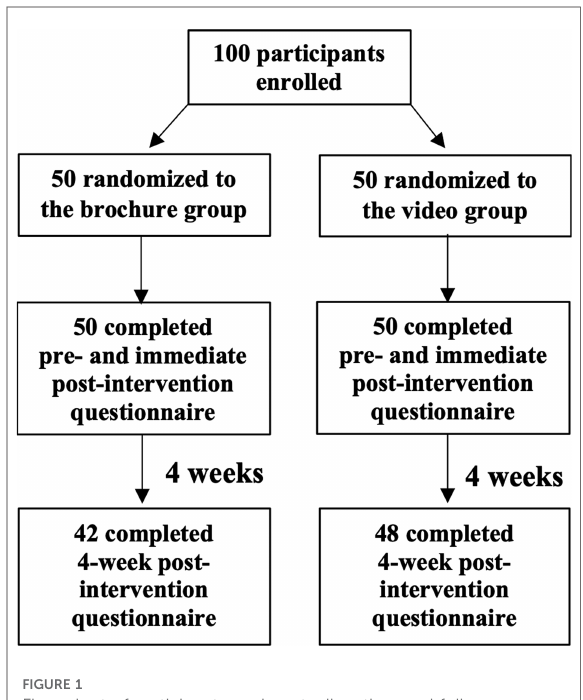
FIGURE 1 Flow chart of participant enrolment, allocation, and